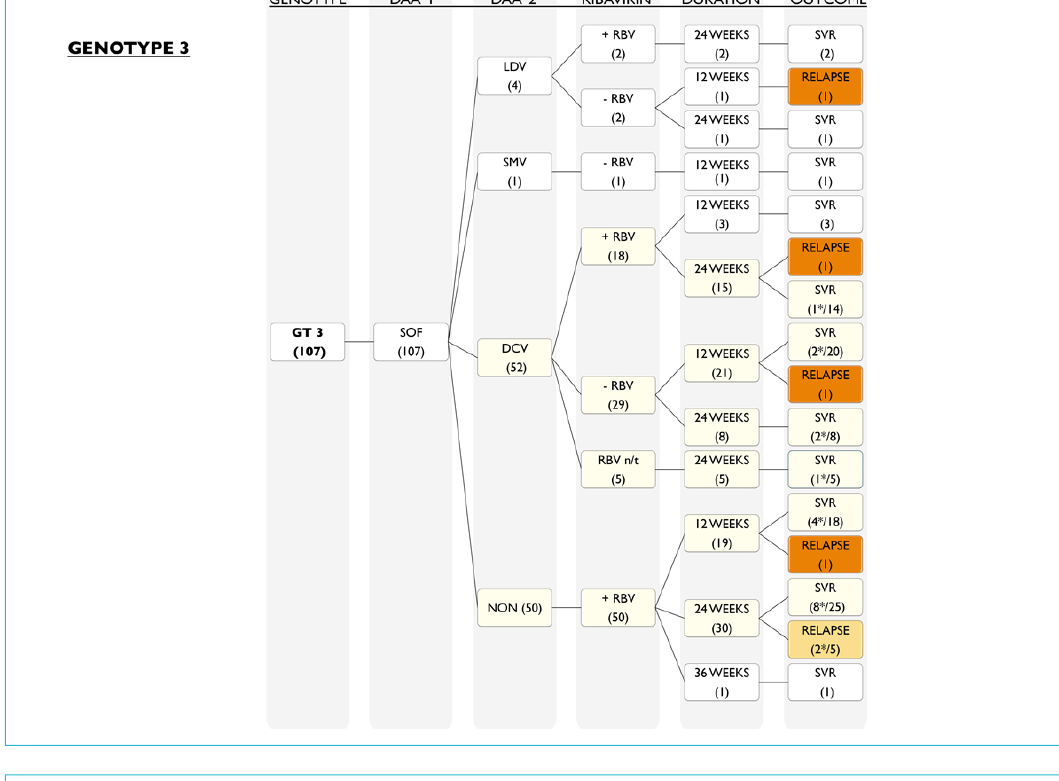
Figure S4: Patients with genotype